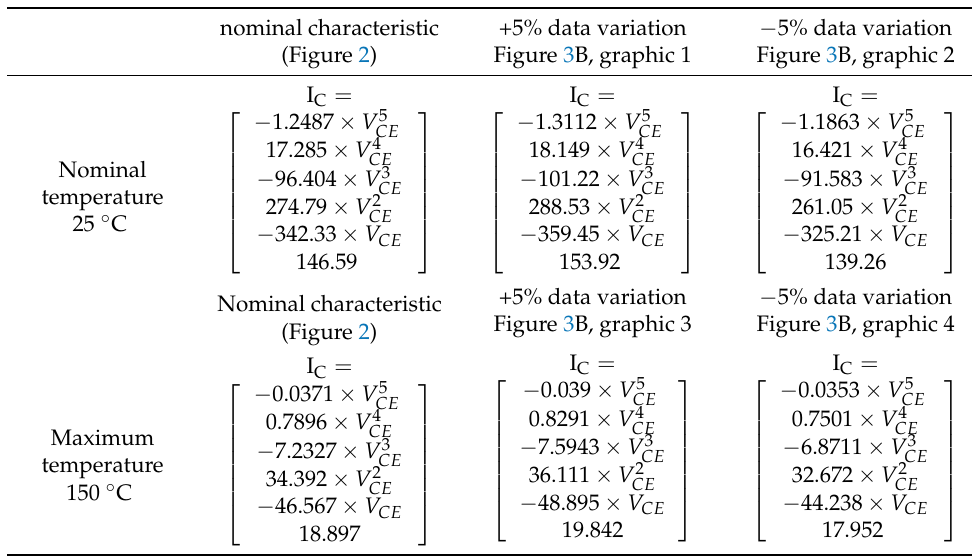
Table 2. Digitalisation of the output characteristics shown in Figure